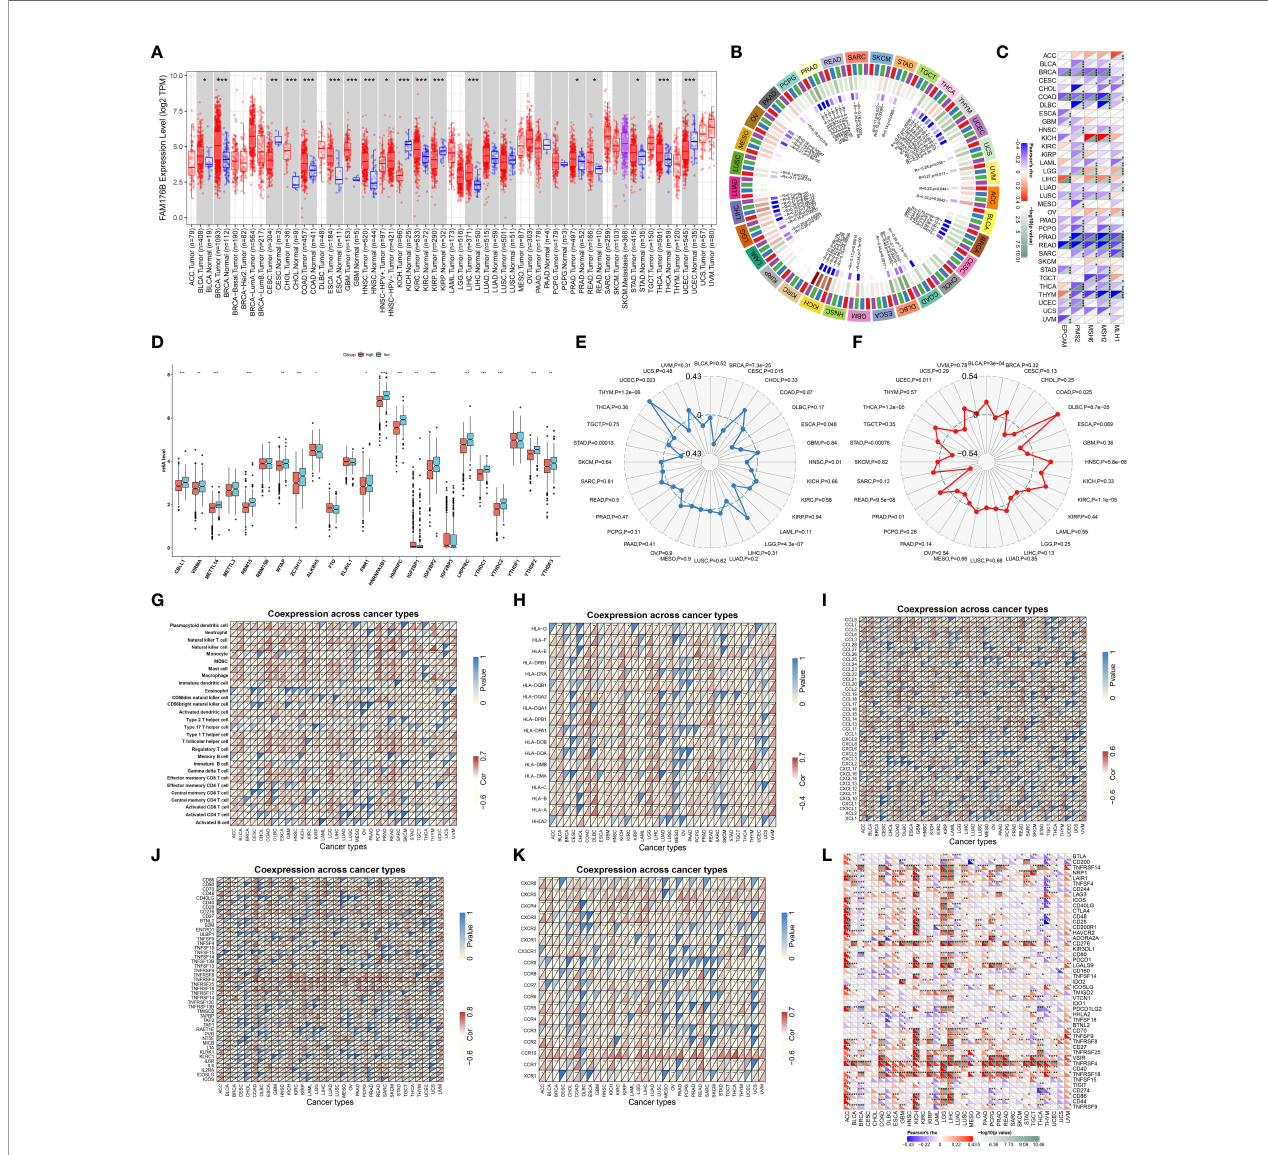
FIGURE 2 | Analysis of expression, genetic and epigenetic alterations, and immunological characteristics of EVA1B across pan-cancer. (A) TIMER analysis identi fi es the difference in expression of EVA1B between diverse cancer types and matched normal specimens. (B) Circle diagram visualizes the interaction of EVA1B with four major DNA methyltransferases: DNMT1, DNMT2, DNMT3A, and DNMT3B across pan-cancer. The fi rst outer ring, cancer types; the second ring, four DNA methyltransferases; the third ring, correlation coef fi cients; the fourth ring, p -values; and numbers in the inner ring, correlation coef fi cients and p -values. (C) Heatmap visualizes the relationship of EVA1B with fi ve DNA mismatch repair genes: MLH1, MSH2, MSH6, PMS2, and EPCAM across diverse cancer types. For each relationship, the top left triangle is colored to indicate correlation coef fi cients, while the bottom right triangle is colored to indicate p -values. (D) Box plots depict the difference in expression of m 6 A regulators in high and low EVA1B expression groups across CRC specimens. (E) Radar chart shows the association of EVA1B with TMB in each cancer type. (F) Radar chart shows the association of EVA1B with MSI across pan-cancer. (G – L) Heatmaps visualize the association of EVA1B with (G) tumor-in fi ltrating immune cells, (H) MHC molecules, (I) chemokines, (J) immunostimulatory factors, (K) receptors, and (L) immune checkpoint molecules across cancer types. For each relationship, the top left triangle is colored to indicate p -values, while the bottom right triangle is colored to indicate correlation coef fi cients. ACC, adrenocortical carcinoma; BLCA, bladder urothelial carcinoma; BRCA, breast invasive carcinoma; CESC, cervical squamous cell carcinoma and endocervical adenocarcinoma; CHOL, cholangiocarcinoma; COAD, colon adenocarcinoma; DLBC, lymphoid neoplasm diffuse large B-cell lymphoma; ESCA, esophageal carcinoma; GBM, glioblastoma multiforme; HNSC, head and neck squamous cell carcinoma; KICH, kidney chromophobe; KIRC, kidney renal clear cell carcinoma; KIRP, kidney renal papillary cell carcinoma; LAML, acute myeloid leukemia; LGG, lower-grade glioma; LIHC, liver hepatocellular carcinoma; LUAD, lung adenocarcinoma; LUSC, lung squamous cell carcinoma; MESO, mesothelioma; OV, ovarian serous cystadenocarcinoma; PAAD, pancreatic adenocarcinoma; PCPG, pheochromocytoma and paraganglioma; PRAD, prostate adenocarcinoma; READ, rectum adenocarcinoma; SARC, sarcoma; SKCM, skin cutaneous melanoma; STAD, stomach adenocarcinoma; TGCT, testicular germ cell tumors; THCA, thyroid carcinoma; THYM, thymoma; UCEC, uterine corpus endometrial carcinoma; UCS, uterine carcinosarcoma; UVM, uveal melanoma. (* p < 0.05; ** p < 0.01; *** p <